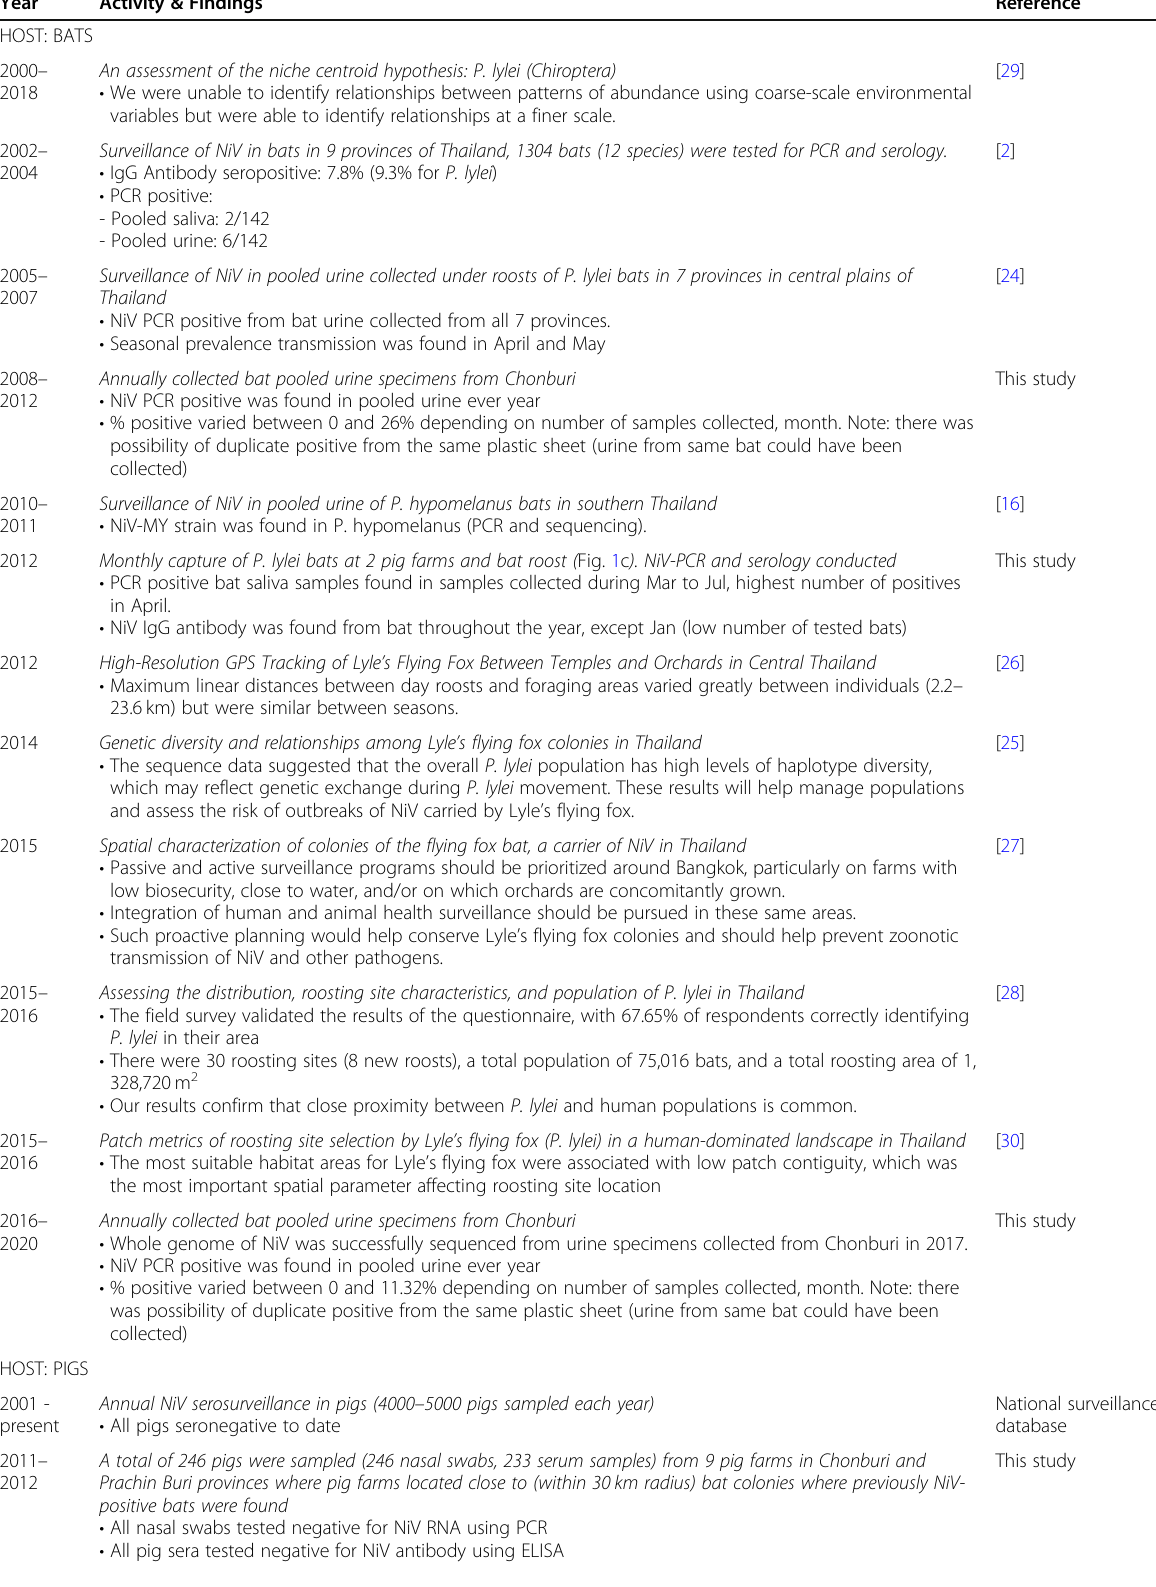
Table 1 Timeline of NiV-related activities as part of the triangulated surveillance in the past two decades in